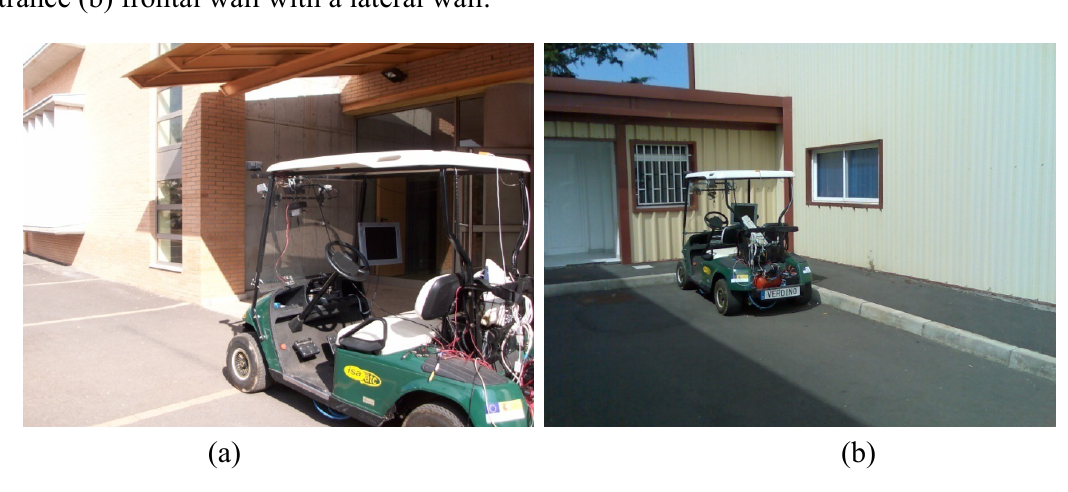
Figure 11. Photographs of the other scenarios used in the experiments: (a) building entrance (b) frontal wall with a lateral wall.